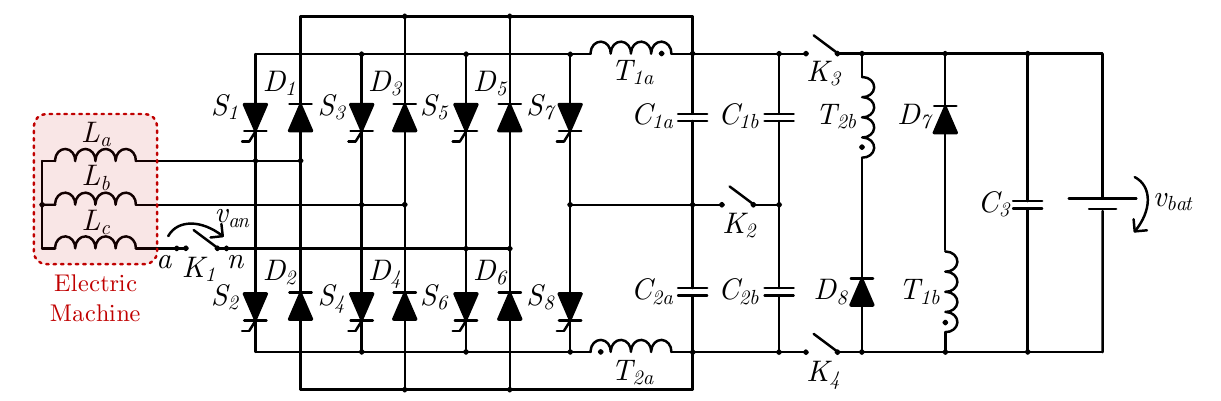
Figure 2. EV IBC proposed by D. Thimmesch in 1983 [10].